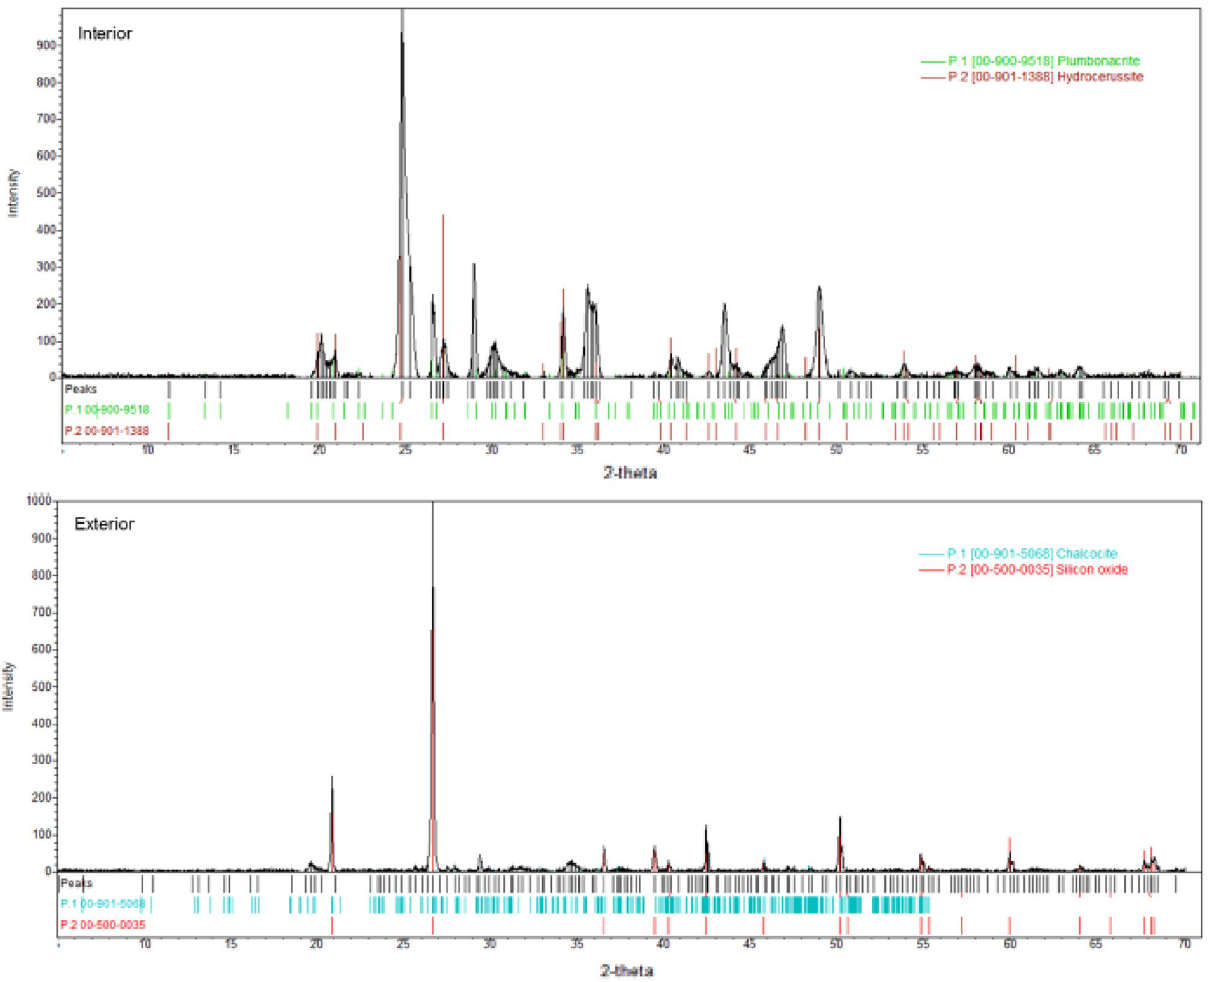
Figure 4. Diffractograms obtained by XRD for the Vessel A corrosion with phase identification plumbonacrite and hydrocerusside identified in the interior sample, chalcocite and silicon oxide (quartz) identified in the exterior